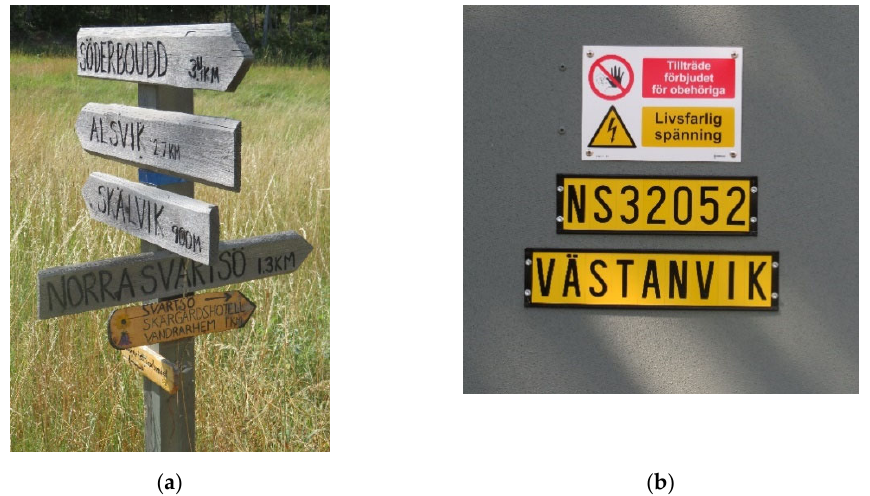
Figure 3. Examples of signs providing general information and instructions: ( a ) Signposts at a cross ‐ roads on Svartsö; ( b ) warning signs and a place name on an electricity sub ‐ station on Nämdö.